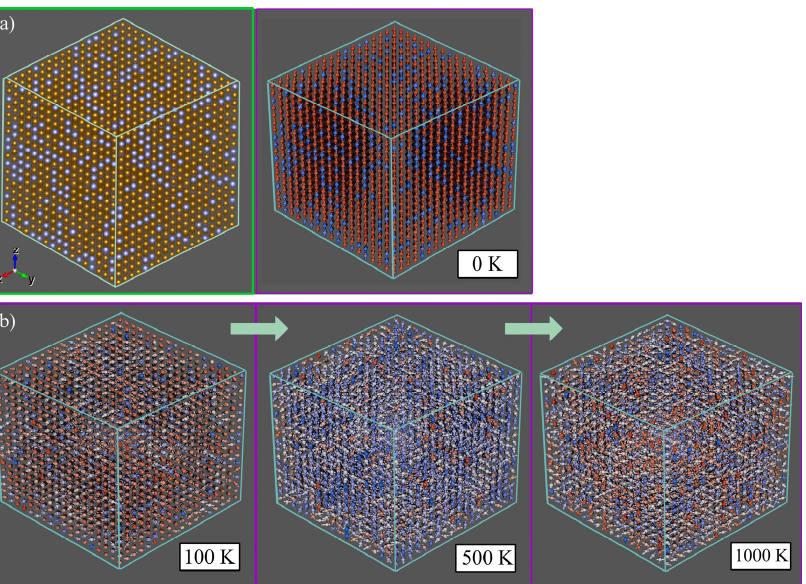
Figure 5. The representation of spin configurations of simulated Fe 75 Gd 25 (bcc) alloy ( J Fe ‐ Gd = − 1.380 × 10 − 21 J/link) at the initial state (0 K) with antiferromagnetic Fe/Gd order ( a ) and with the temperature increase ( b ). The color changes with the spin projection. The pure red and pure blue colors represent directions opposed to each other. The leftmost image in ( a ) shows the visualization of the simulated structure (color scheme the same as in Figure 1).